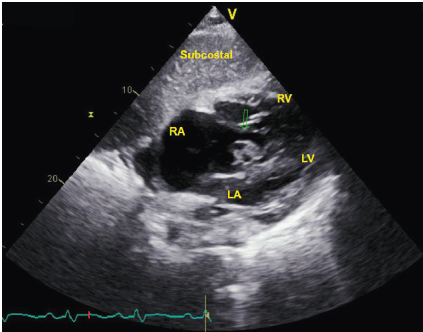
Figure 1: Apical view showing the tricuspid valve vegetation and apical displacement of the tricuspid valve.